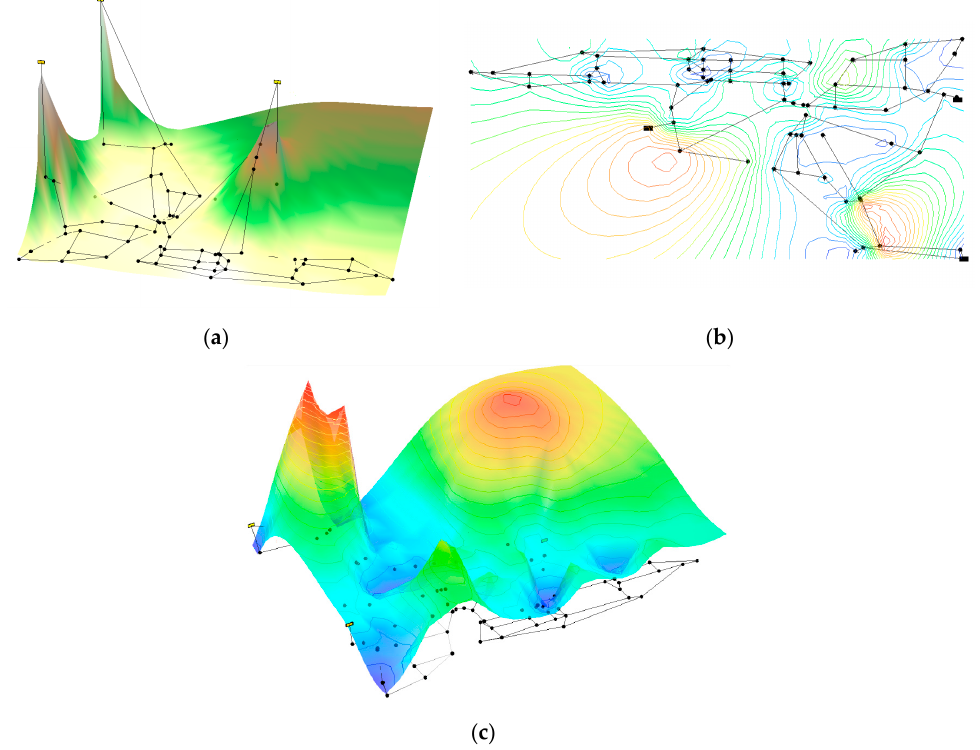
Figure 6. ( a ) Topographic profile for Pescara. ( b ) Level curve for the HGL . ( c ) Assigned surface for the Pescara network.